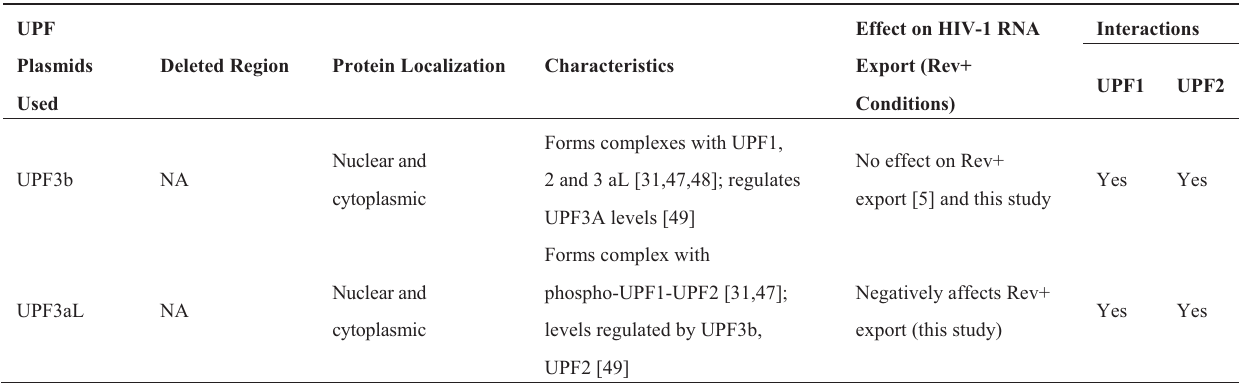
Table 2. UPF2 and UPF3